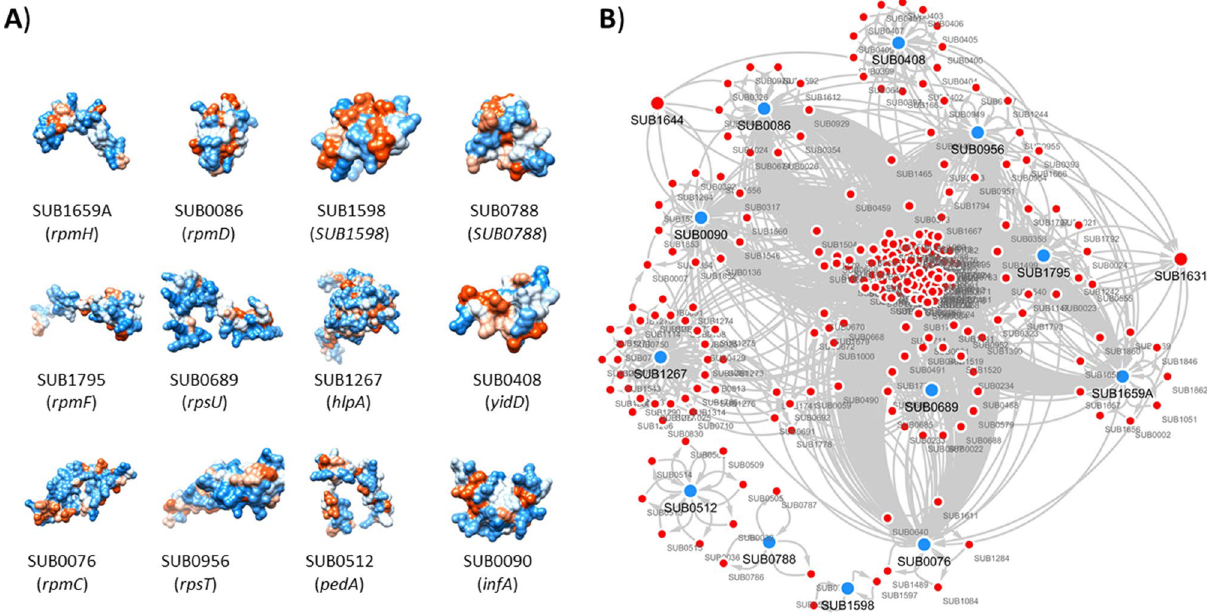
Figure 5. Protein–protein interaction network of the discriminant proteins found to correspond to the MALDI-TOF spectral peaks recognized as significant by the trained classifiers. ( A ) 3D homology structures of the 12 discriminant proteins. ( B ) The Protein–protein interaction network showing the 12 discriminant proteins (blue circles) and the 239 S. uberis proteins (red circles) to which they interact with (first shell interacting partners). Amongst these first shell interacting partners, two proteins—SUB1644 (ksgA) and SUB1631 (fusA)— are related to antimicrobial